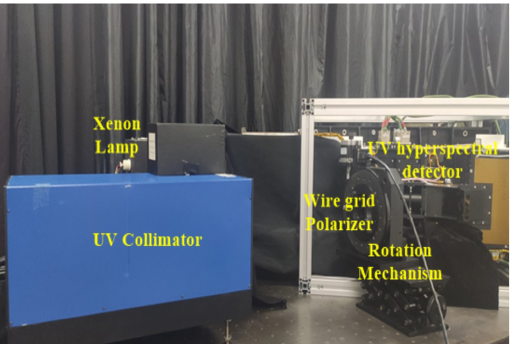
Figure 8. Calibration test diagram of polarization characteristics of UV Hyperspectral Detector. The polarization response calibration results of the UV Hyperspectral Detector are shown in Figure 9. The scanning mirror angle was 13.6 ◦ .